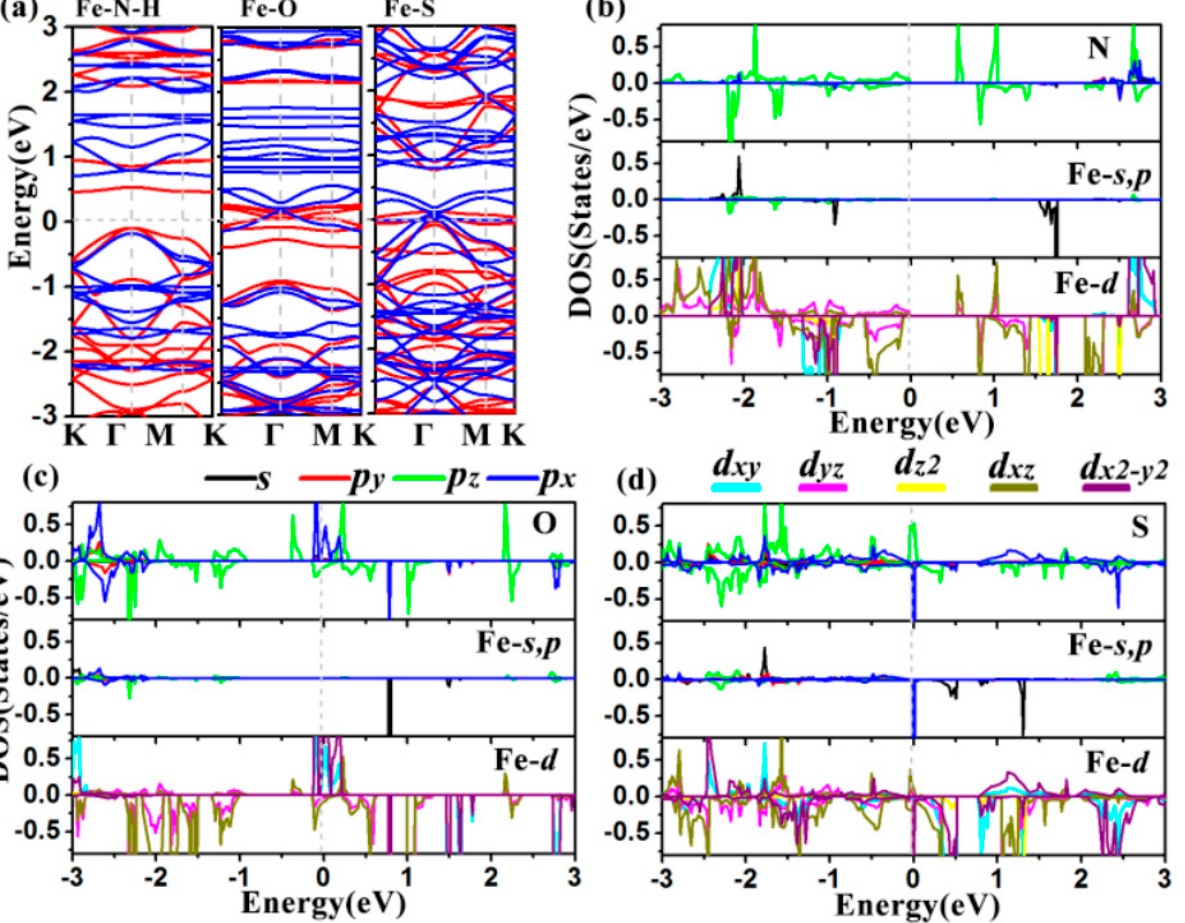
Figure 4. Band structures ( a ) and projected density of states (PDOS) of ( b ) Fe-N-H-MOF, ( c ) Fe-O- MOF, and ( d ) Fe-S-MOF monolayers. The Fermi levels (EF) are set to 0 eV.